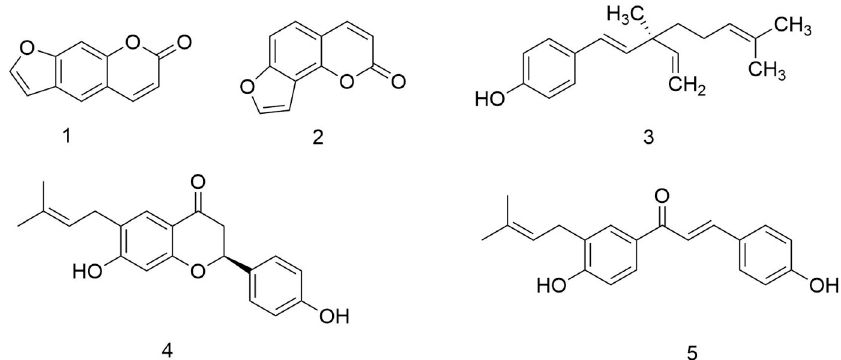
Figure 1. The structure of effective components of Psoralea corylifolia L. Compounds depicted above include ( 1 ) psoralen, ( 2 ) isopsoralen, ( 3 ) bakuchiol, ( 4 ) bavachin, and ( 5 ) isobavachalcone.